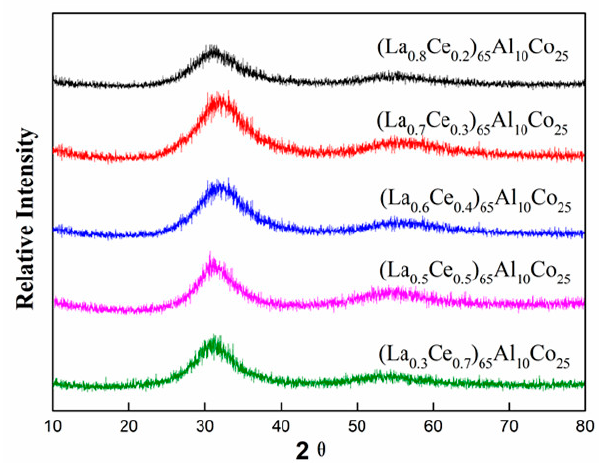
Figure 1. XRD (X-ray diffraction) patterns of the as-cast LaCe-based BMGs (bulk metallic glasses).